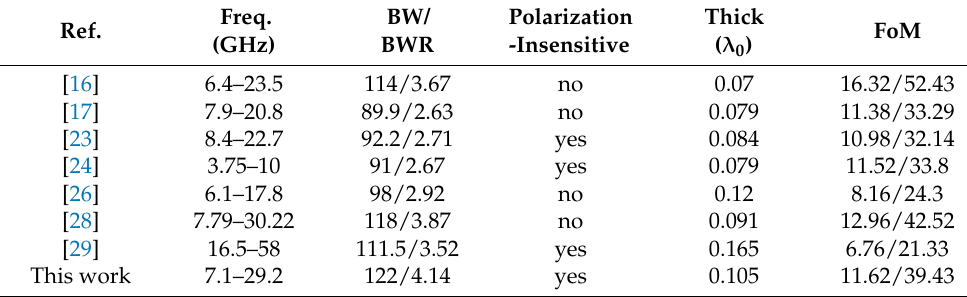
Table 1. Comparison With Other Wideband RCS Reduction Design. Ref.